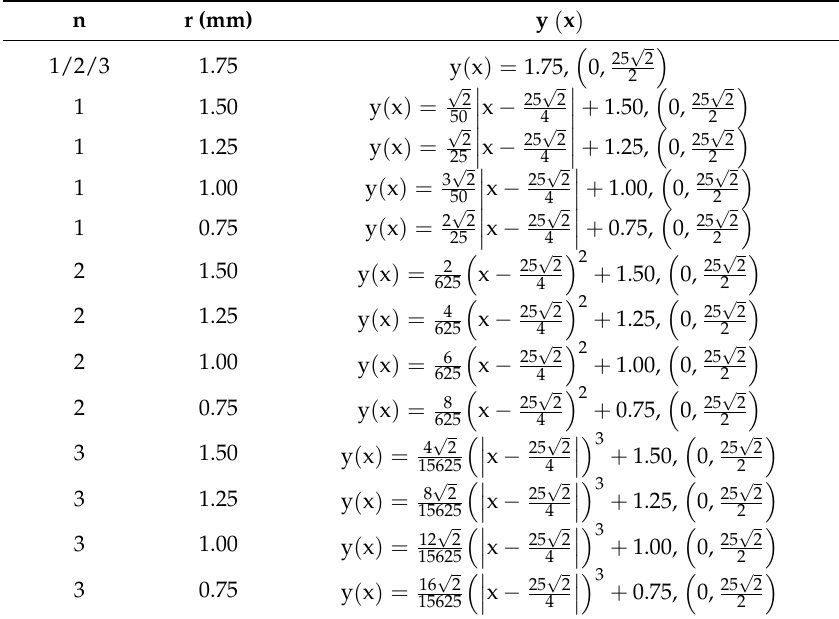
Figure 4. Manufactured 2-D lattice structures with variable cross-section cores. 3. Analytical Model